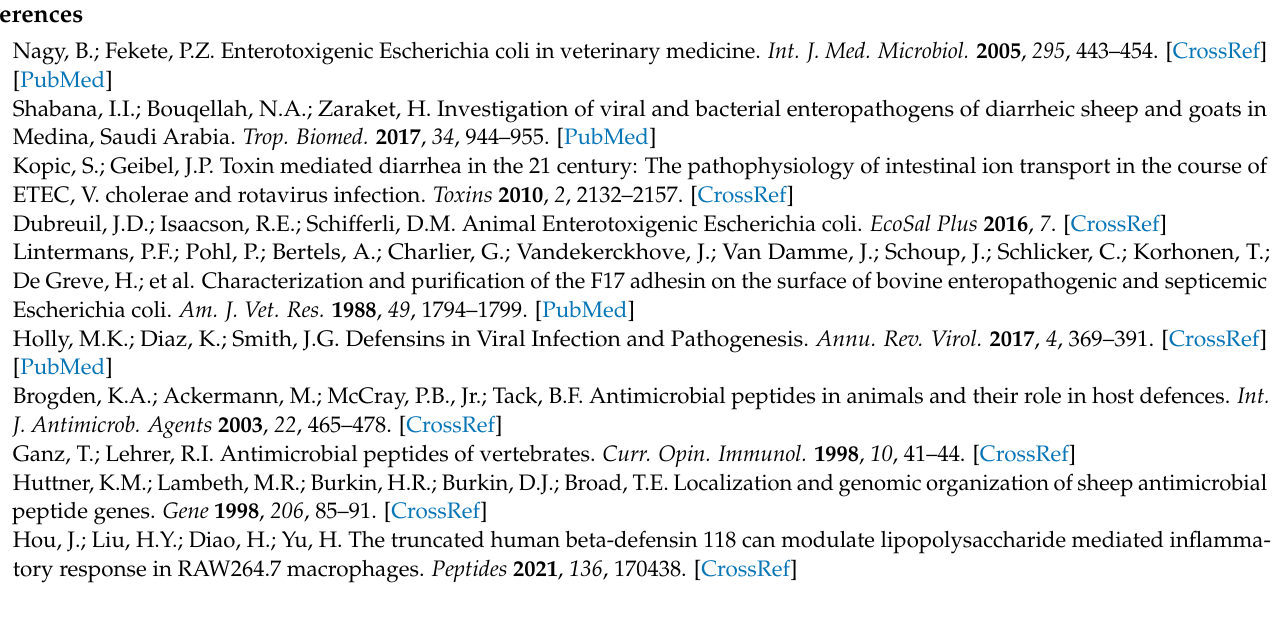
Illustration of pGH-SBD-2 plasmid construction, Figure S3: Ovine intestinal epithelial cells of Hu sheep under inverted microscope, × 40, Figure S4: Agarose gel electrophoresis of cell total RNA, Figure S5: E. coli F17 stimulates mRNA and protein expression levels of SBD-2, Table S1: A detailed description of the clinical symptoms, laboratory characteristics and identification of E. coli F17, Table S2: Specific primers used for RT-PCR, Table S3: Primers used in plasmid construction, Table S4: Sequence information of RNA oligonucleotides, Table S5: Reaction systems and procedures for